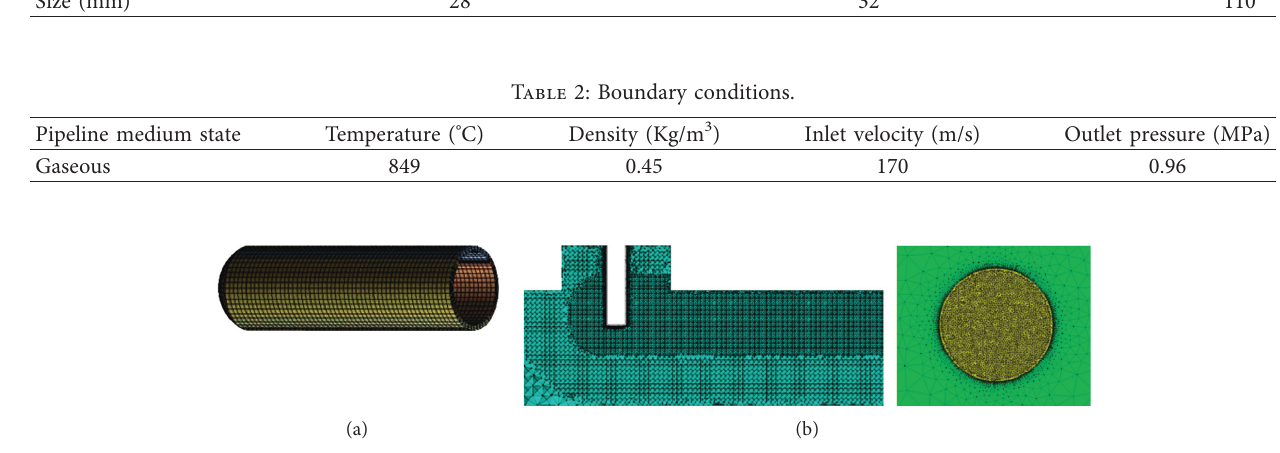
Figure 2: Meshing. (a) Solid domain meshing. (b) Fluid domain meshing. Table 3: Grid independence